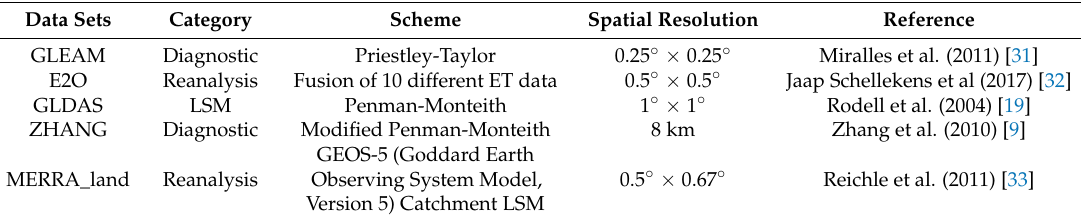
Table 2. Overview of the evapotranspiration (ET) products used in this